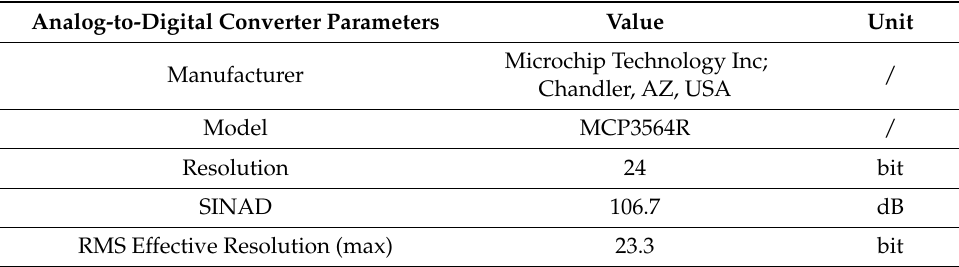
Table 4. Table of analog-to-digital converter